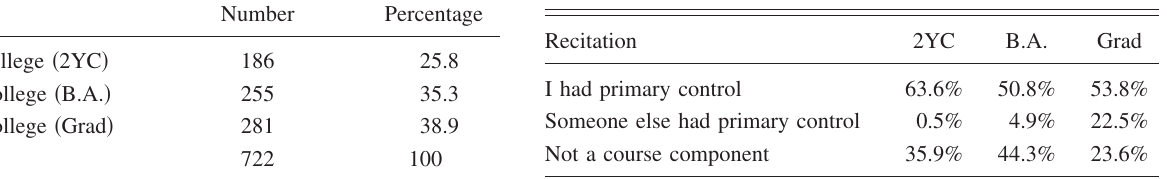
TABLE IV. Existence of and control over recitation or discus- sion section component of the course.